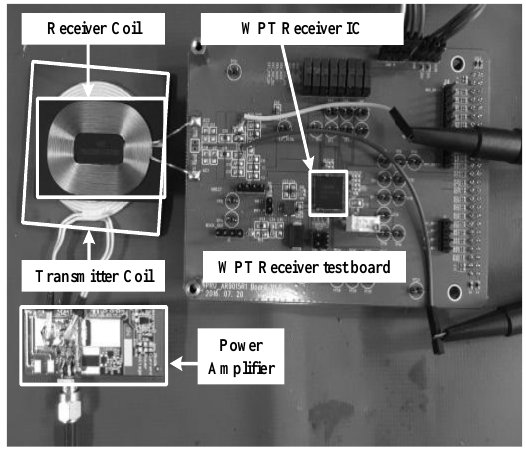
Figure 10. Measurement environment of the wireless power receiver.